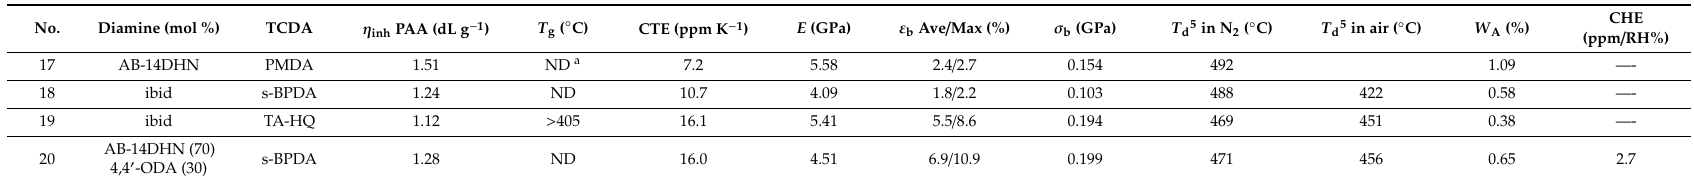
Table 5. Film properties of the PEsIs derived from AB-14DHN with tetracarboxylic dianhydrides (TCDA) and related